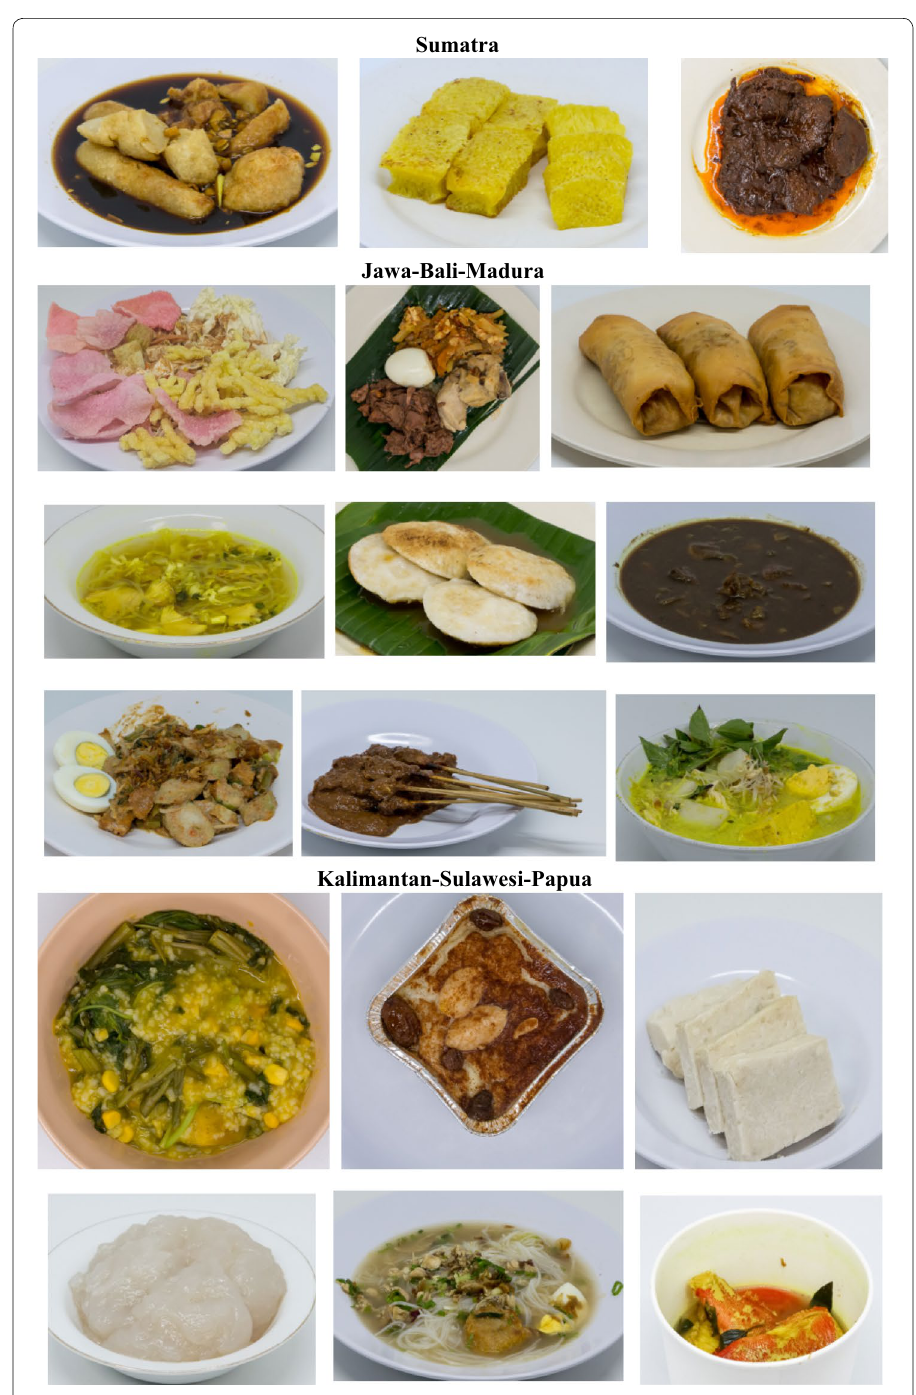
Fig. 2 Sample images from the traditional food image